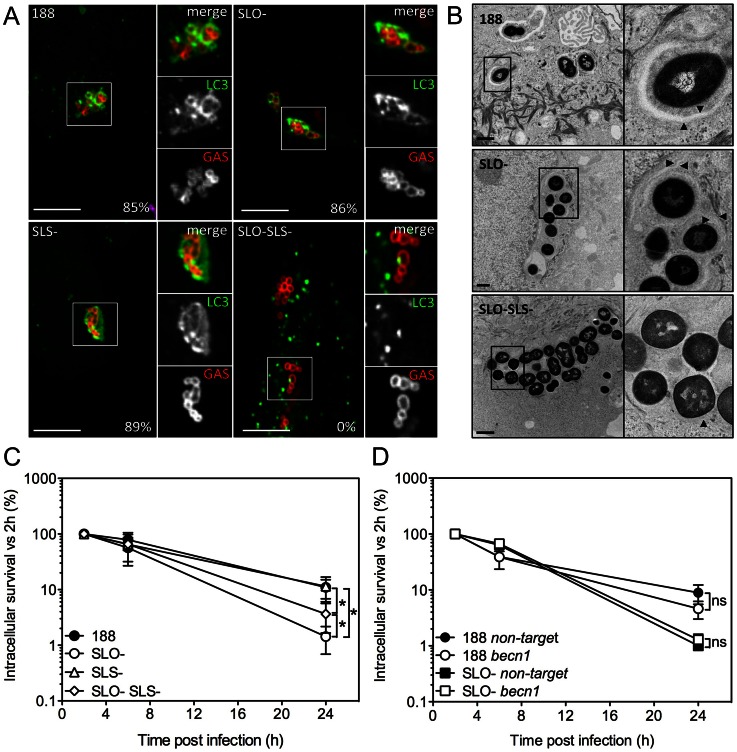
Xenophagy in oropharyngeal keratinocytes can be stimulated by SLO or SLS and is not associated with killing of intracellular GAS.
A. Confocal microscopy of the association between EGFP-LC3 and GAS strain 188, 188SLO- (SLO-), 188SLS- (SLS-), or 188SLO-SLS- (SLO-SLS-). Immunofluorescent staining distinguished intracellular (Alexa-568, red) from extracellular (Alexa-568 and Alexa-660, red and blue, respectively) GAS. Scale bar = 10 µm. The percent of intracellular GAS that were associated with EGFP-LC3 at 3 h post-infection is shown for each strain. B. Electron microscopy of GAS strains 188, 188SLO-, and 188SLO-SLS- at 3 h post-infection. Arrowheads indicate the presence of double or multiple membranes (188 and 188SLO-) or single membranes (188SLO-SLS-) partially or completely surrounding bacteria. Vacuolar compartments associated with 188 and 188SLO- also contain cytosolic material. C. Intracellular survival of GAS strains 188, 188SLO-, 188SLS-, and 188SLO-SLS-. *, P<0.05. D. Intracellular survival of 188 or 188SLO- in the presence or absence of Beclin1 knockdown.